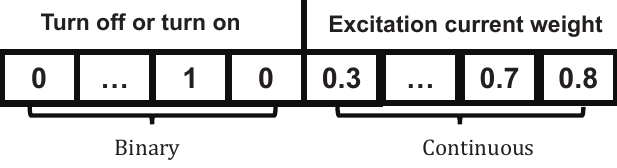
Figure 2. Inactivated or activated antenna